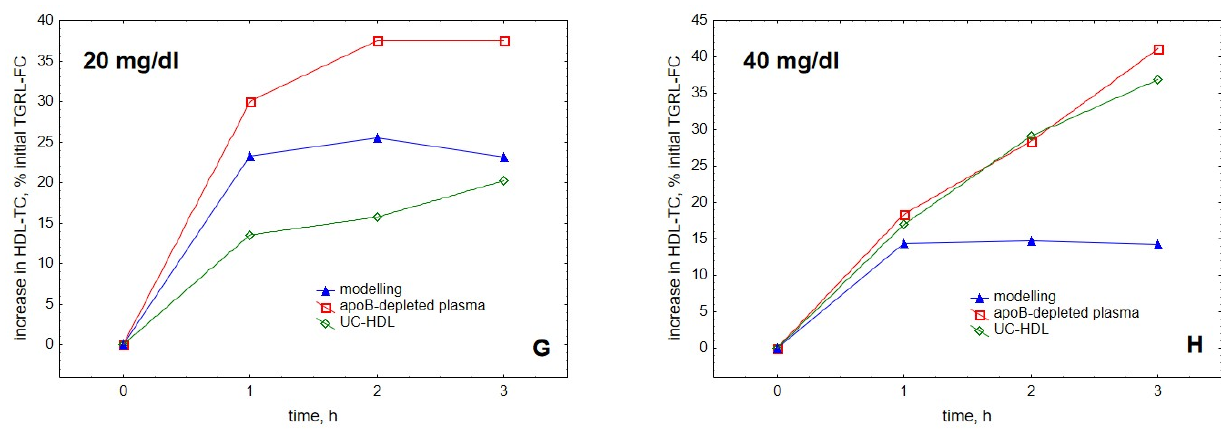
Figure 4. Comparison of the kinetics of accumulation in HDL of FC ( A – D ) and TC ( E – H ) with experimental data obtained for HDL isolated by ultracentrifugation or by apoB precipitation [25]. Experimental data for HDL isolated by ultracentrifugation and apoB precipitation are shown as green diamonds and red squares, respectively, whereas modelling results are presented as black circles for FC and blue triangles for TC. As the experimental data do not distinguish between TC and FC and are expressed relative to the initial content of FC in TGRL, all the data are expressed as a percentage of the initial TGRL-FC. Mathematical modelling was performed under conditions of in vitro TGRL lipolysis described elsewhere [25]. In order to calculate accumulation in HDL of FC or TC, its content at baseline (t = 0) was subtracted from the results of the modelling and expressed as a percentage of the initial VLDL content of FC, according to [25]. Initial concentrations: HDL, 5 ( A,E ), 10 ( B , F ), 20 ( C , G ) and 40 ( D , H ) mg total mass/dl (shown in the upper left corner of each panel); VLDL-TG, 30 mg/dl; LPL, 190 U/mL.